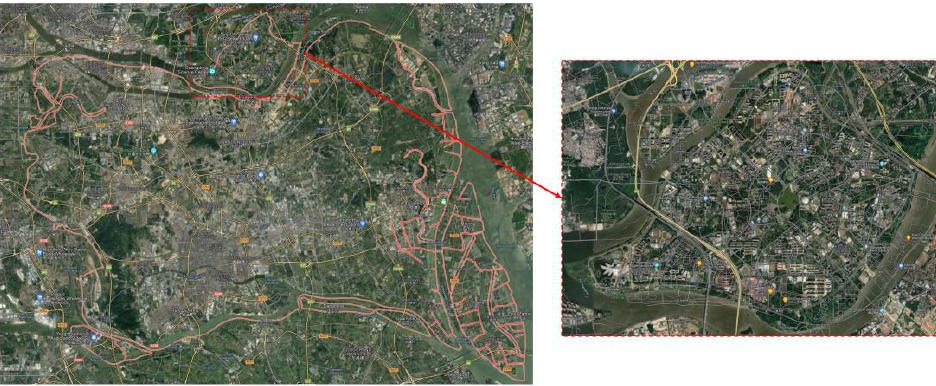
Figure 13. Location and geographic information of the University Town in Panyu District. Table 6. Populations under different noise exposure levels in the University Town.